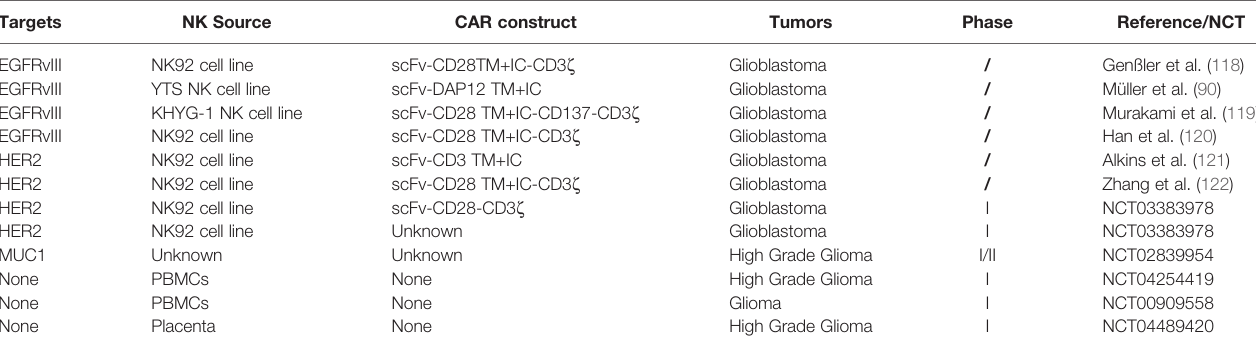
TABLE 3 | Applications of NK cells in glioma.